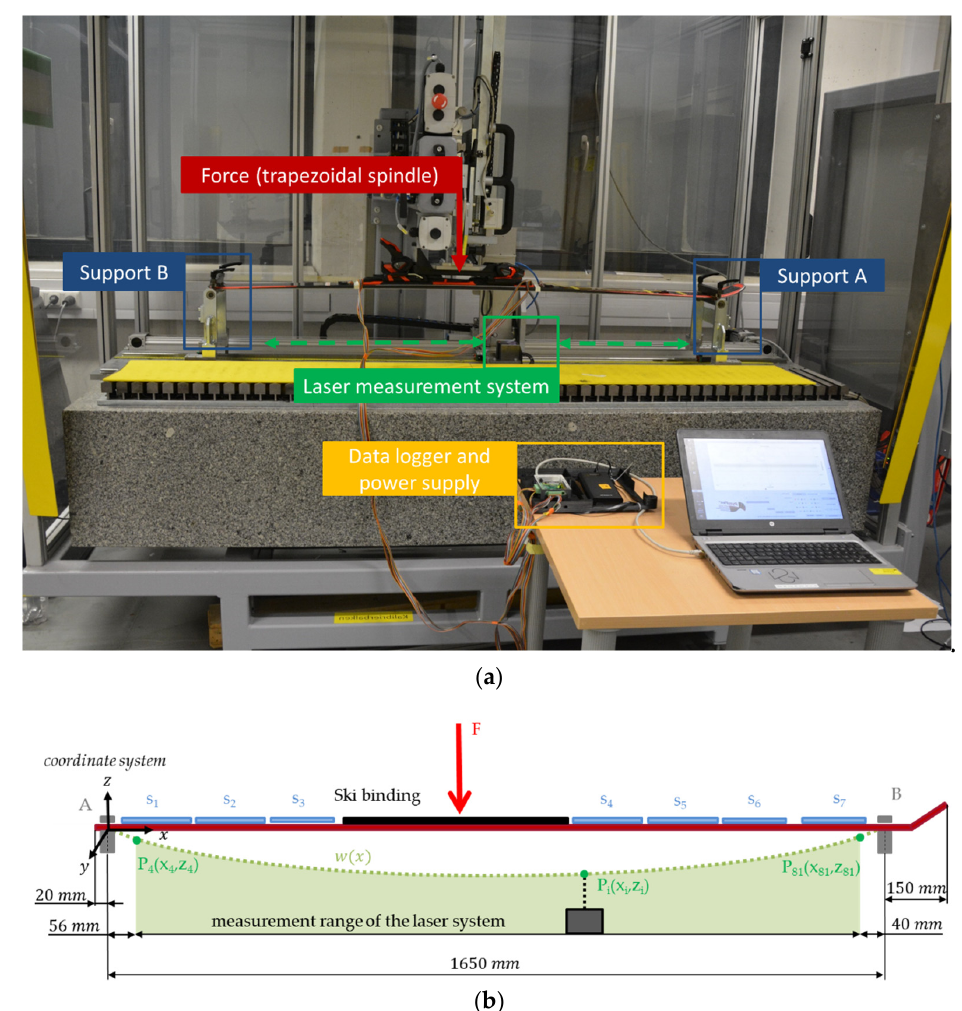
Figure 3. Three-point bending test with an integrated laser measurement system (Atomic GmbH); ( a ) picture with the corresponding experimental components; ( b ) schematic drawing of the experi- mental setup. N = 83 data points were captured over a length of 1650 mm (78 points directly by the laser measurement system ( P 4 ( x 4 , z 4 ) to P 81 ( z 81 , z 81 ) ) and 5 points